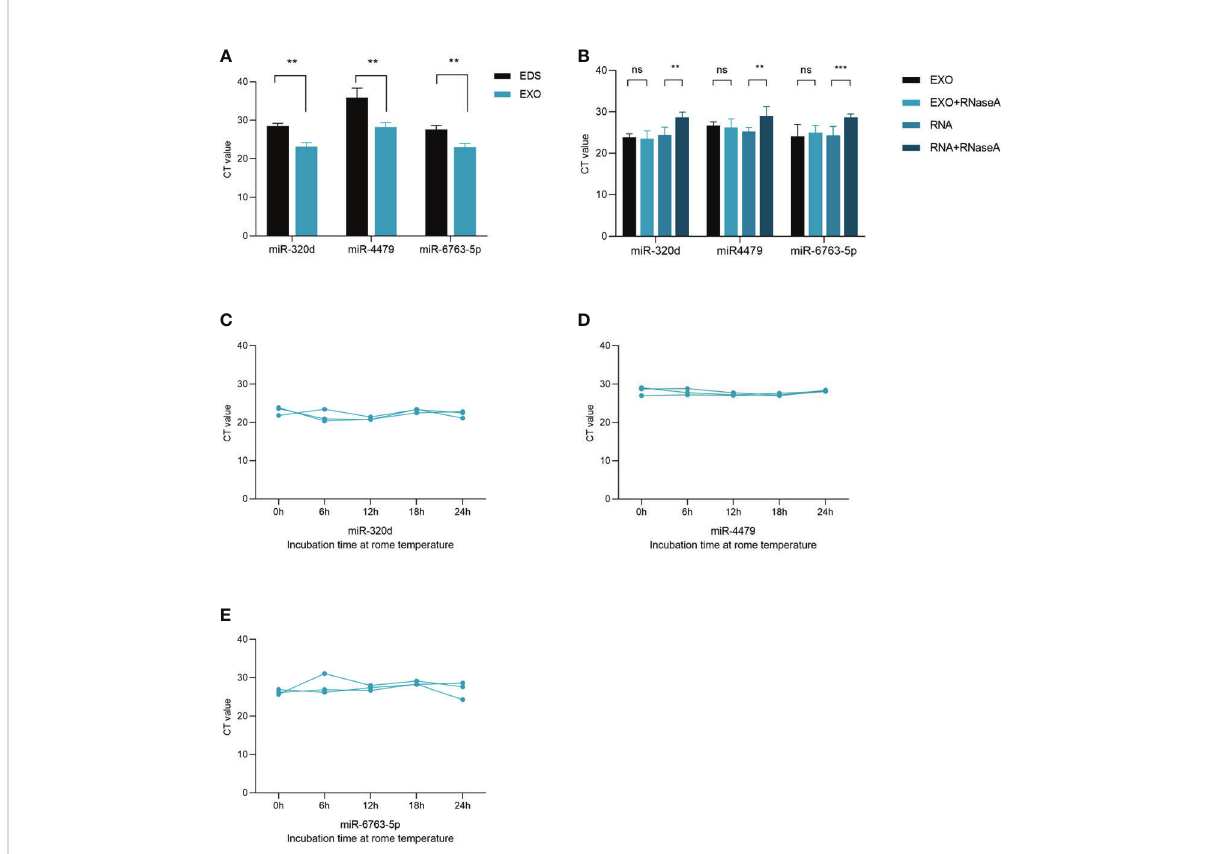
FIGURE 4 Characterization of identi fi ed three plasma exosomal miRNAs. (A) Expression levels of miR-320d, miR-4479, and miR-6763-5p from plasma exosomes (EXO) and exosome-depleted supernatant (EDS). (B) Expression levels of both miRNAs in exosomes treated with RNase A or in isolated RNA. (C – E) The expressions of three plasma exosomal miRNAs when incubated at room temperature (** P < 0.01, *** P < 0.001, ns, not signi fi